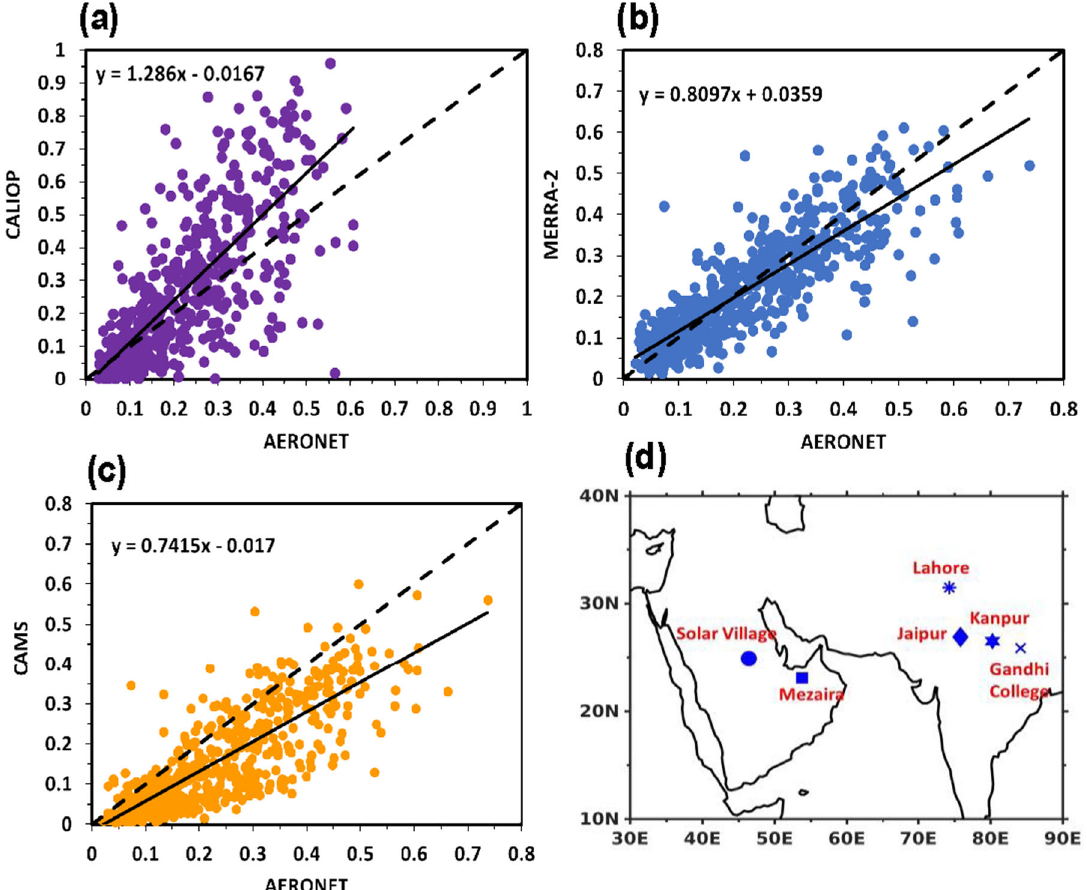
Fig. 1 Comparison of satellite and reanalysis dust products with AERONET dust measurements. Evaluation of a CALIOP, b MERRA-2, and c CAMS DAOD against the AERONET coarse-mode optical depth for all sites across West Asia during the January 2003 – December 2017. The black dashed line represents 1:1 slope line and the black solid line represents the actual slope. The locations of AERONET stations are indicated as blue colored markers in d